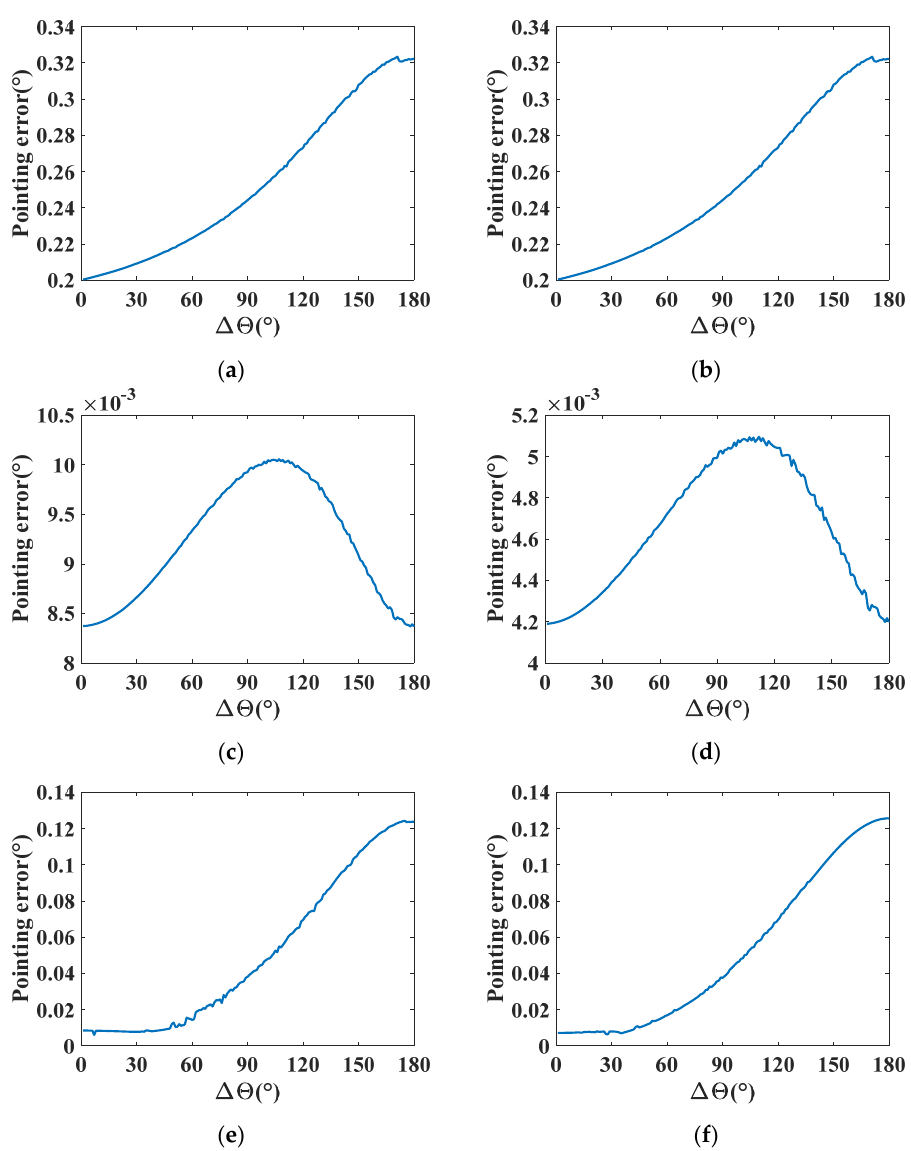
Figure 7. The inverse solution error caused by different systematic errors. ( a ) The incident light horizontally tilted by 0.1 ◦ . ( b ) The incident light vertically tilted by 0.1 ◦ . ( c ) The prism 1 rotation axis horizontally tilted by 0.1 ◦ . ( d ) The prism 1 rotation axis vertically tilted by 0.1 ◦ . ( e ) The prism 2 rotation axis horizontally tilted by 0.1 ◦ . ( f ) The prism 2 rotation axis vertically tilted by 0.1 ◦